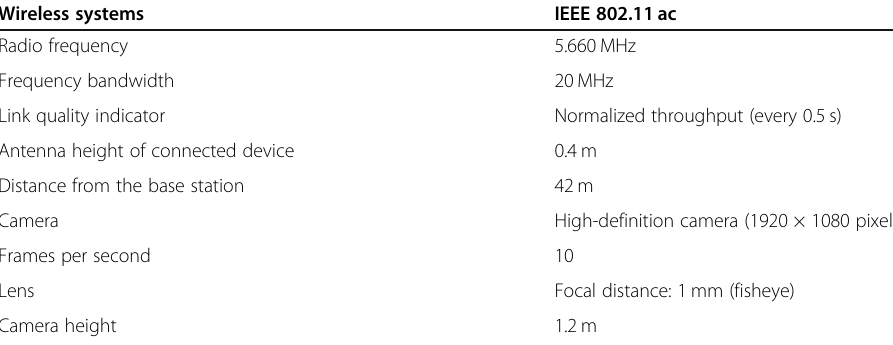
Table 1 Outdoor experiment